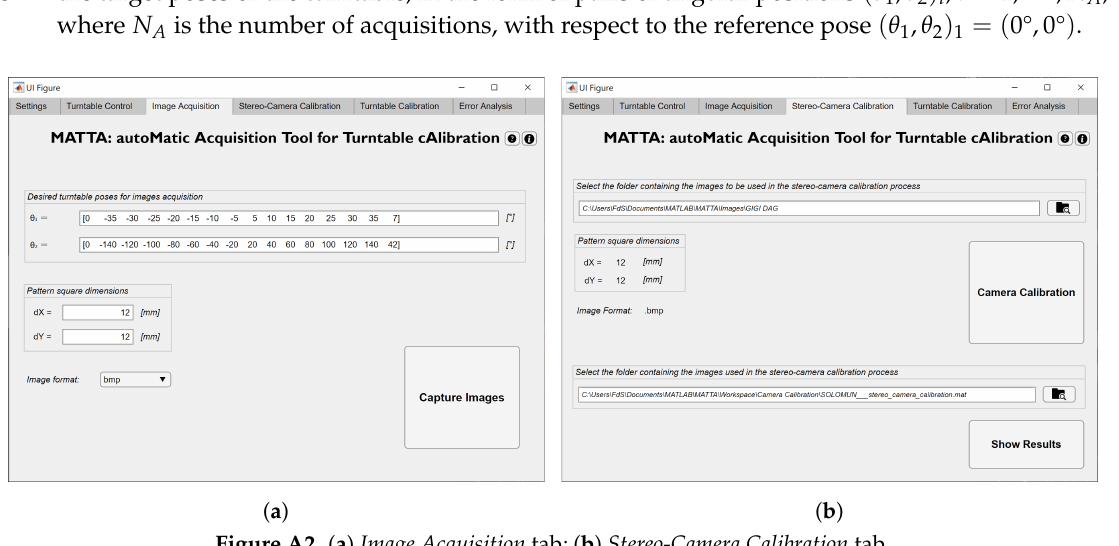
Figure A2. ( a ) Image Acquisition tab; ( b ) Stereo-Camera Calibration